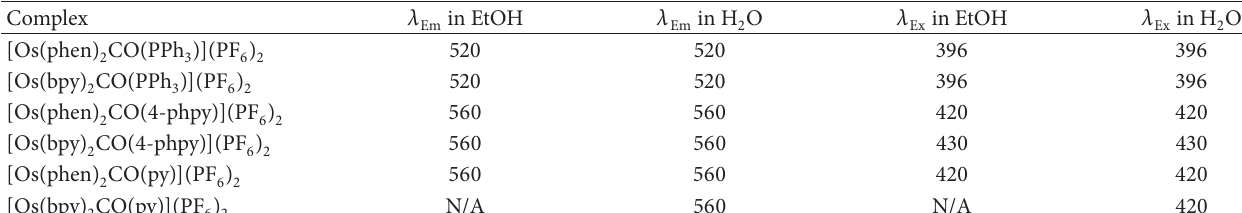
Table 1: Excitation and emission maxima wavelengths (nm) of the six osmium complexes.